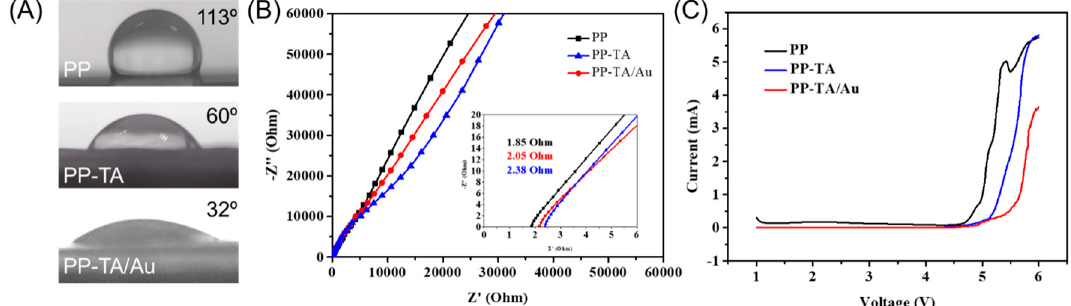
Figure 4. ( A ) Water contact angle of PP, PP-TA and PP-TA / Au separator. ( B ) EIS spectra of stainless steel / electrolyte saturated separator / stainless steel cell assembled with PP, PP-TA and PP-TA / Au separator. ( C ) LSV curve of Li foil / electrolyte saturated separator / stainless steel cell assembled with PP, PP-TA and PP-TA / Au separator.